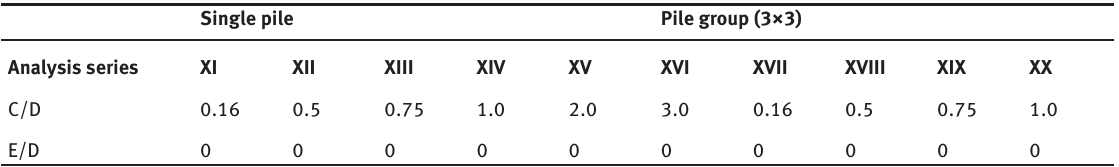
Table 4: Analysis series for a single and group of piles with different depth ratio (C/D). Single